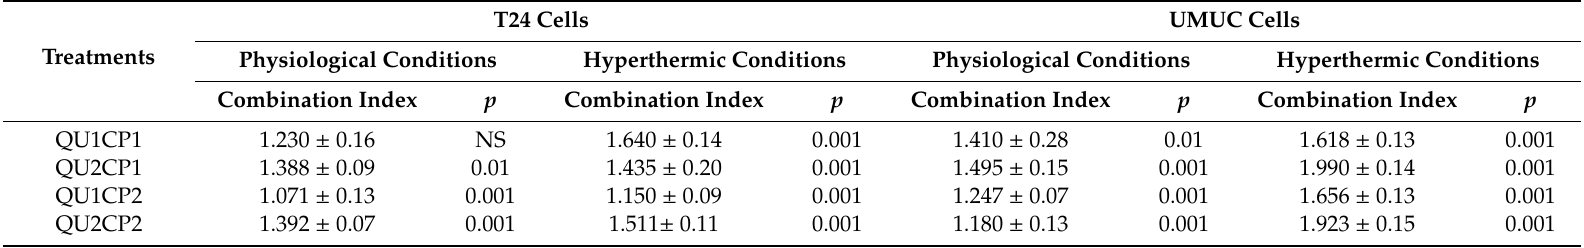
Table 1. Combination index values of the interactions between the inhibitory e ff ect of quercetin and cisplatin under physiological and hyperthermic conditions on the survival of T24 and UMUC cells.